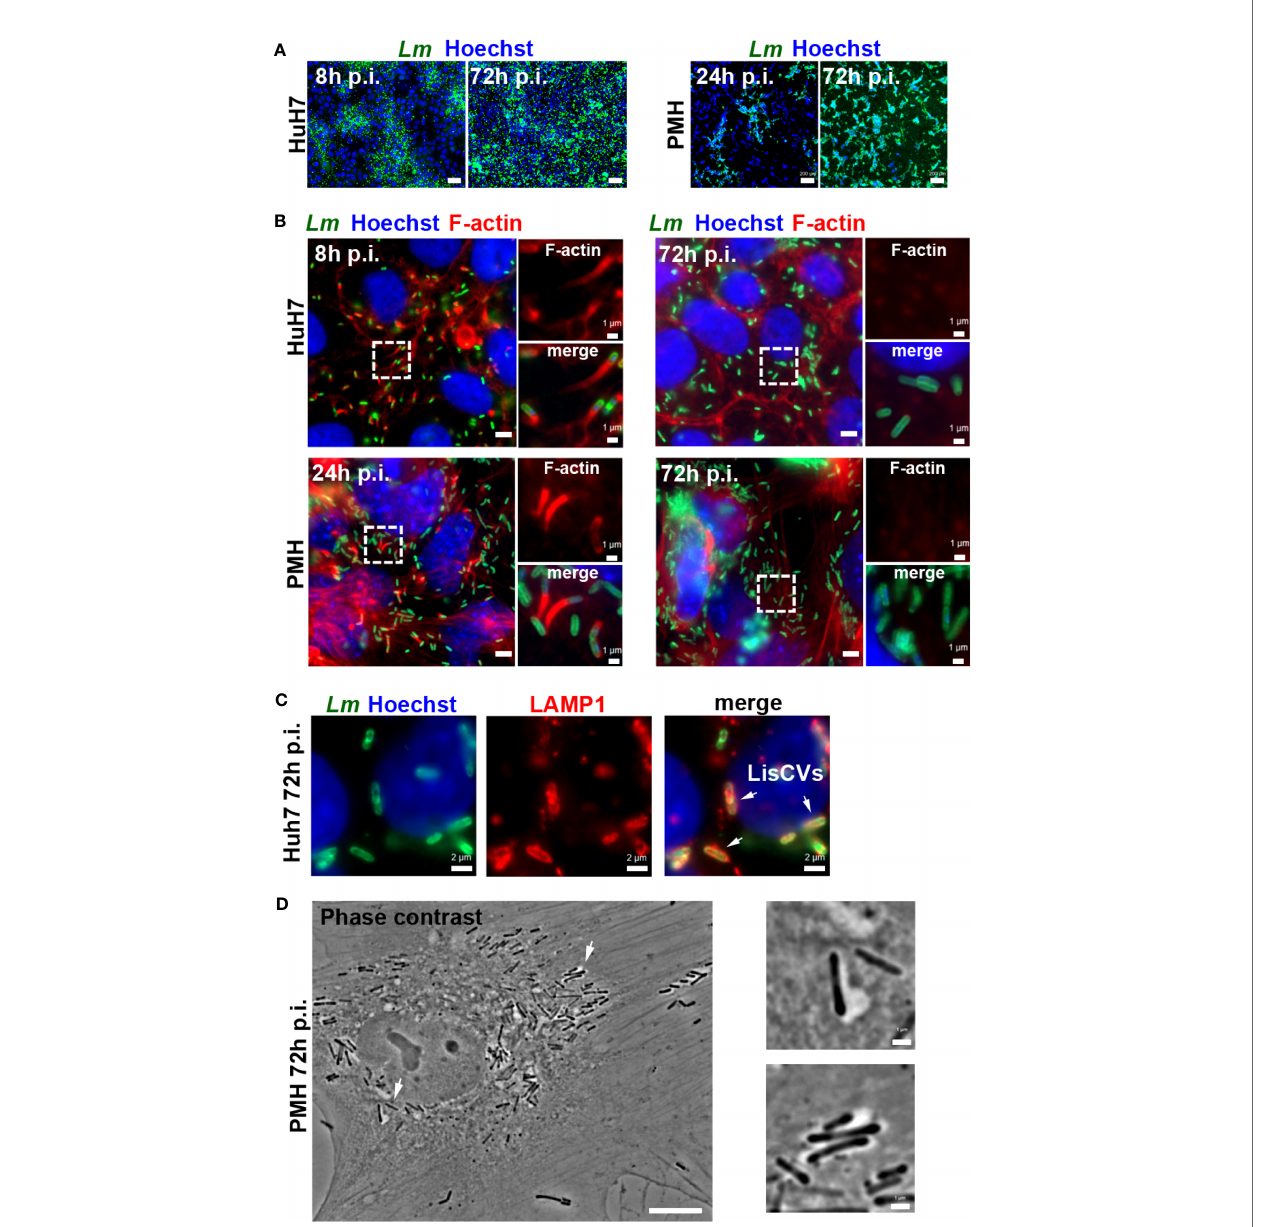
FIGURE 1 | Optimization of hepatocyte culture systems for modeling persistent Listeria infection. Different cell seeding conditions, MOI and Listeria strains (EGDe or 10403S) were tested to obtain optimal long-term Listeria infection of HepG2 (see Supplementary Figure S1 ), Huh7 or PMH. Infected cells were examined at day 1 (d1) and at day 3 (d3) by immuno fl uorescence microscopy: representative examples under optimized conditions are shown. (A) Low magni fi cation micrographs of Huh7 cells infected with EGDe strain (MOI=1-5) or PMH infected with 10403S strain (MOI=10) for the indicated time. Images are overlays of Listeria (green) and Hoechst (blue) signals (bars: 50 µm, Huh7, or 200 µm, PMH). (B) High magni fi cation micrographs of infected Huh7 or PMH showing Listeria (green), F-actin (red) and Hoechst (blue) signals. Bars: 5 µm. Boxed regions enlarged on the right show F-actin (top) or merged signals (bottom), highlighting actin-positive bacteria at d1 and actin-negative bacteria at d3 (bars: 1 µm). (C) Micrographs of an infected Huh7 cell at d3, showing Listeria (green), LAMP1 (red) and Hoechst (blue) signals. Arrows indicate 3 examples of LisCVs. (D) Phase contrast image of an infected PMH at d3 (bars: 10 µm). Arrows indicate 2 examples of bacteria within vacuoles, shown at a higher magni fi cation on the right (bars: 1